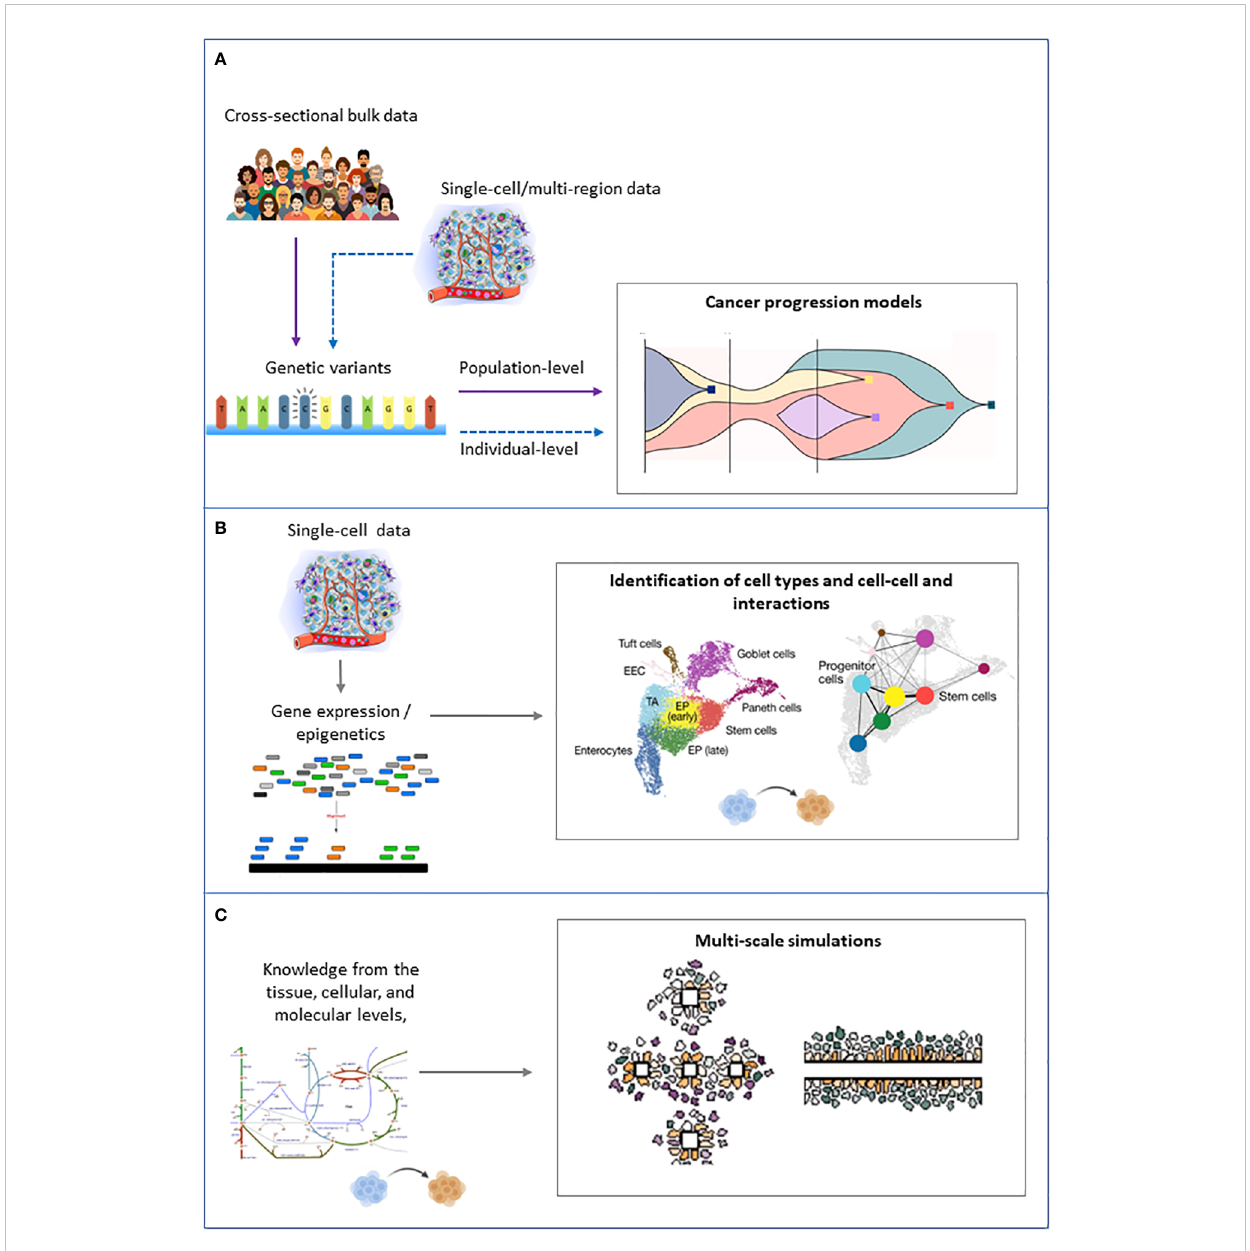
FIGURE 4 Schematic representation of the inputs (left) and outputs (right) of the main families of computational approaches to tackle intratumor heterogeneity. (A) Cancer progression models. (B) Clustering of single cells. (C) Multiscale modeling and